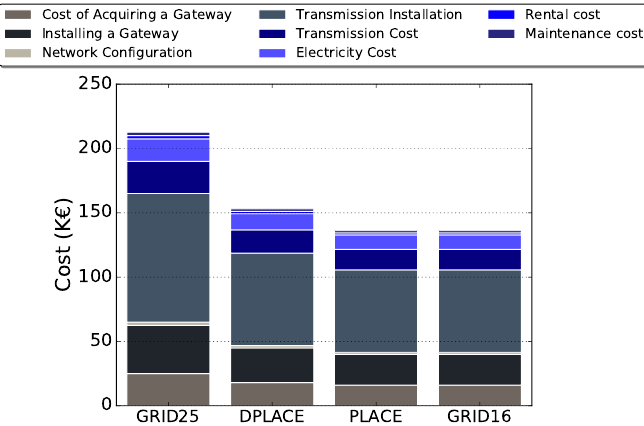
Figure 8. Total cost per specific service for analyzed LoRaWAN gateway placement